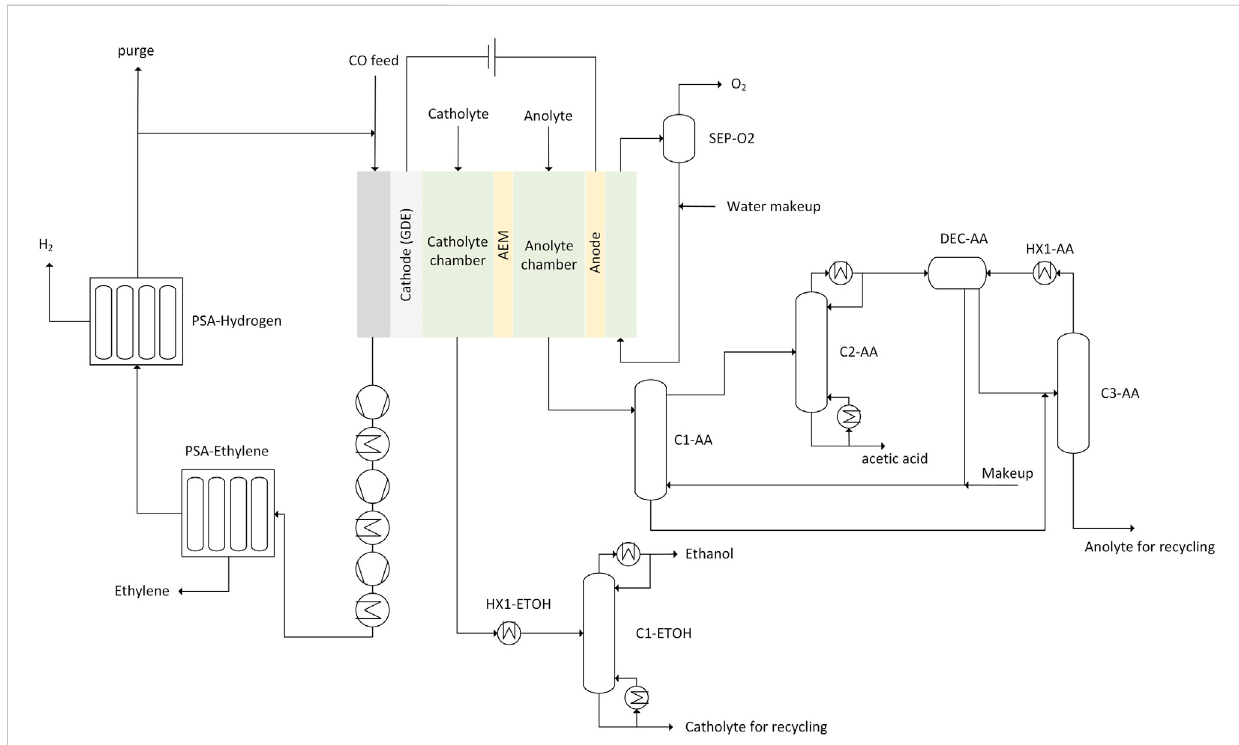
FIGURE 4 SketchoftheelectrochemicalCOreductionincludingthedownstreamproductpuri fi cationandrecyclestreams(GDE,gasdiffusionelectrode;AEM, anion exchange membrane) recycle for catholyte and anolyte including makeup not shown in